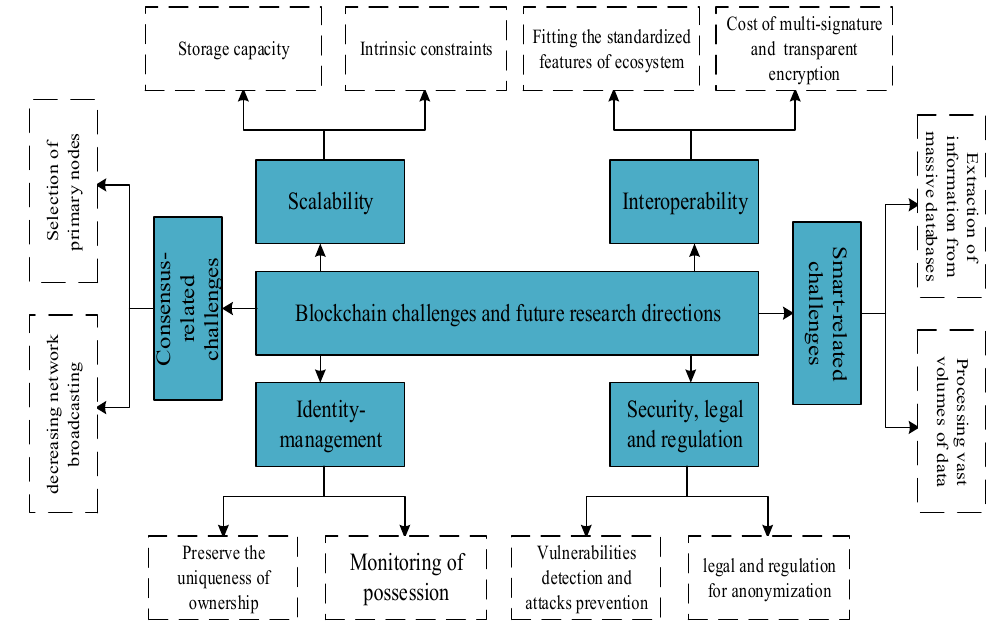
Figure 3. Blockchain challenges and future research directions.